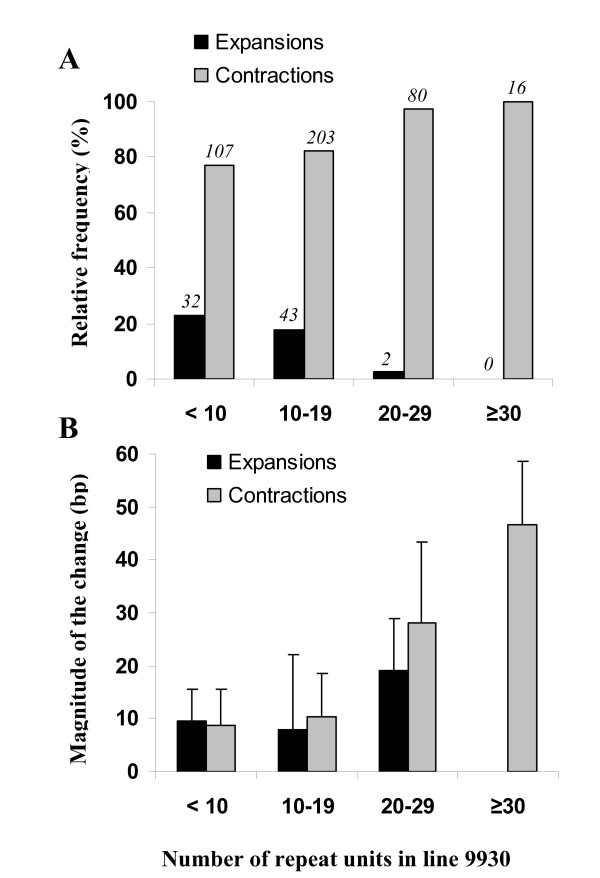
Frequency (A) and magnitude (B) of SSR expansions/contractions in cucumber genotypes Gy14 versus 9930 in relation to the number of repeat units of the microsatellite. The allele from cucumber inbred line 9930 was considered as the reference (or initial state) of the repeat. For each class of 'number of repeat units', the percentage (bars) and actual counts (italic numbers) of SSRs showing expansions or contractions in Gy14 are presented in panel A. The magnitude of the change in allele sizes (∆al) from 9930 and Gy14 is presented in panel B (error bars denote standard deviations). For compound SSRs, repeat units in each uninterrupted repeat were summed if the allele had at least 10 repeat units (e.g., (AT)8(GT)12 = 20 repeat units).